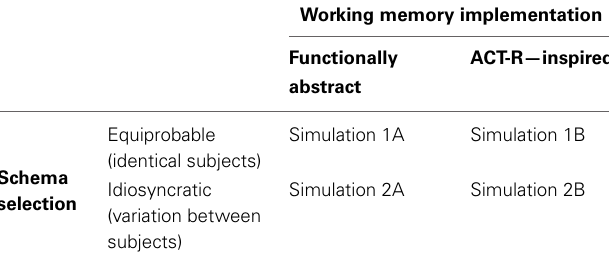
Table 1 | Overview of